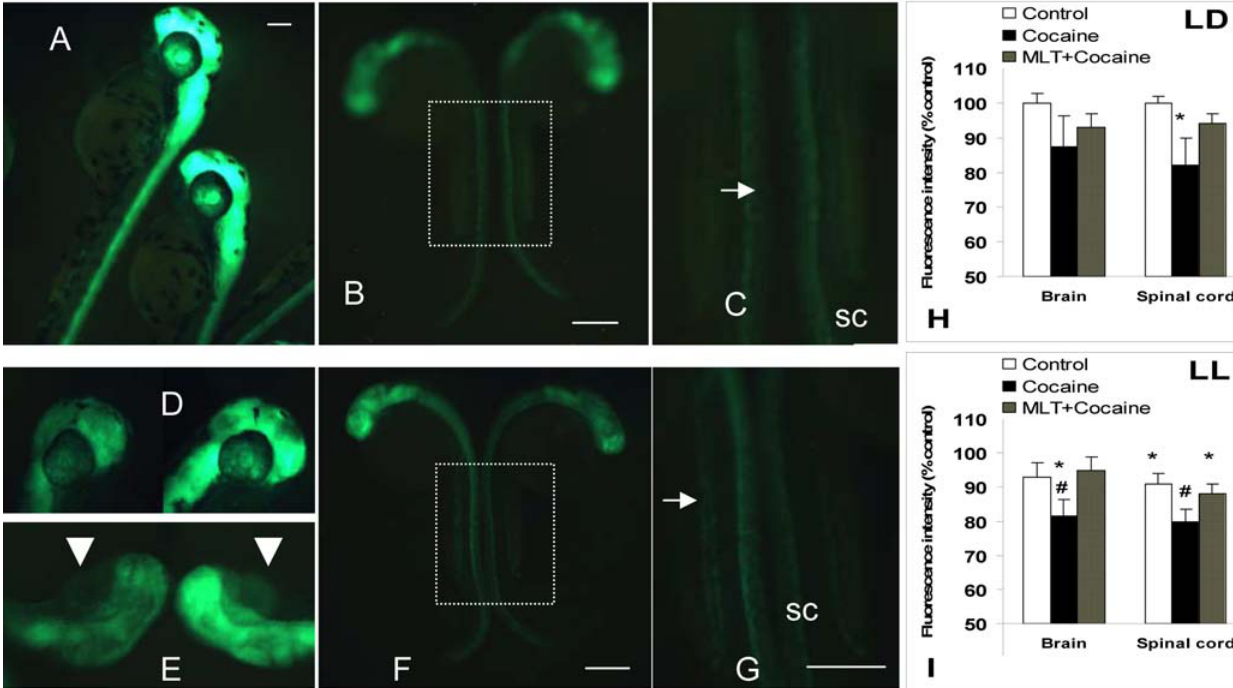
Figure 1. Prenatal exposure to cocaine alters neuronal development in a 1-TGFP transgenic zebrafish embryos. Control embryos ( A : 63 hpf; B and C : 37 hpf) show highly similar patterns of GFP reporter expression. Although major anatomical abnormalities were not found in cocaine-treated embryos, they display variable patterns and typically lower levels of GFP reporter expression ( D – G ) following repeated cocaine administration (1 m M, 15 min every hour for 5 daytime hours, starting at 22–24 hpf). ( C ) and ( G ) correspond to the dotted line areas in ( B ) and ( F ), respectively, and show GFP reporter expression in the spinal cord (sc) and enteric neurons (arrows). Note that a double string of enteric neurons, separated by a prospective lumen, is visible in both control embryos ( c ) but only in one of the cocaine-treated embryos (left in F and G ). ( D) and ( E ) depict different GFP expression patterns in the forebrain of four cocaine-treated embryos (37 hpf): lateral ( D ) and semi-dorsal view (e; arrowheads-eyes). All pictures are original photographs of live, responsive-to-touch embryos of the same clutch, placed next to each other on the cover glass. Black spots in ( A ) and ( D ) represent pigment. Out-of-focus areas on the close-up whole-embryo pictures (e.g., B , F ) are due to the curved position of the embryo around the spherical yolk sack. The pictures are from one of the 12 clutches studied in LD, and are representative of 3 independent experiments. Scale bars: 250 m m. ( H and I ) Mean (SEM) percent change in fluorescence intensity in the brain and spinal cord of 37 hpf embryos raised in LD ( H ) or LL ( I ) conditions, relative to mean Control group intensity in LD (100%). Control (white bar), repeated cocaine (1 m M) administration alone (black bar) or with 30-min melatonin pre-treatment (diagonal bar) at 22 hpf. p , 0.05 * relative to LD Control, or # relative to LL Control (one-way ANOVA), n=28 per treatment